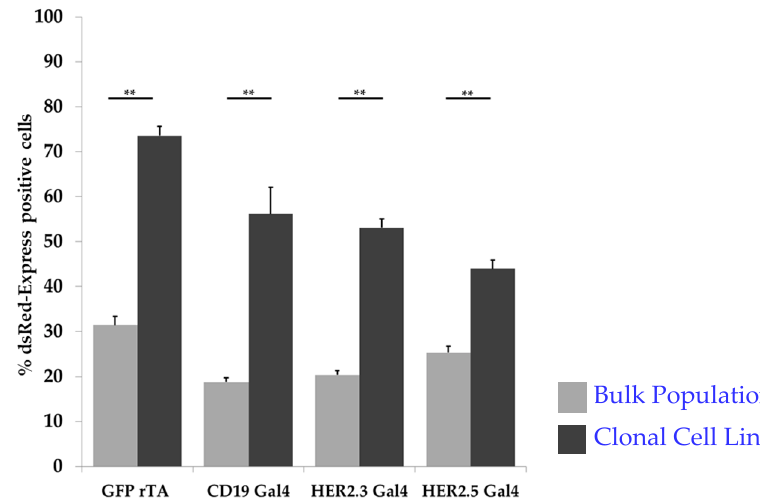
Figure 3. Effect of activation time on synNotch receptor activation: To determine sufficient activation time, synNotch receiver cells were incubated with corresponding antigen-expressing sender cells. After the indicated time points (10, 30, 60, 120, and 180 min), activation was halted. Cells were analyzed 48 h later for dsRed-Express fluorescence ( n = 3). Cells 2020 , 9 , 1929